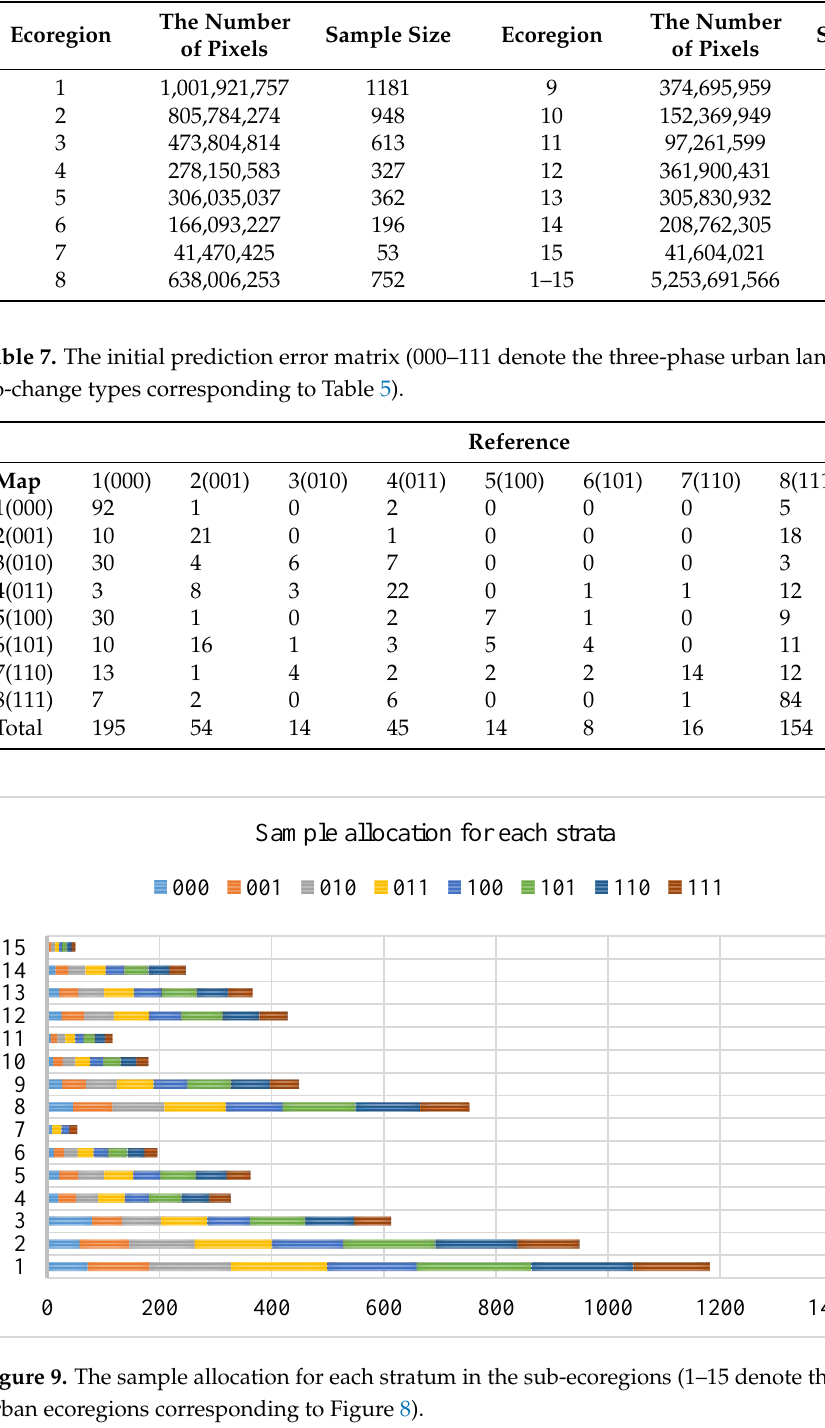
Table 6. Sample size for the pixels in each ecological region (1–15 denote the index of the urban ecoregions corresponding to Figure 8). The Number Sample Size Ecoregion Ecoregion of Pixels 1